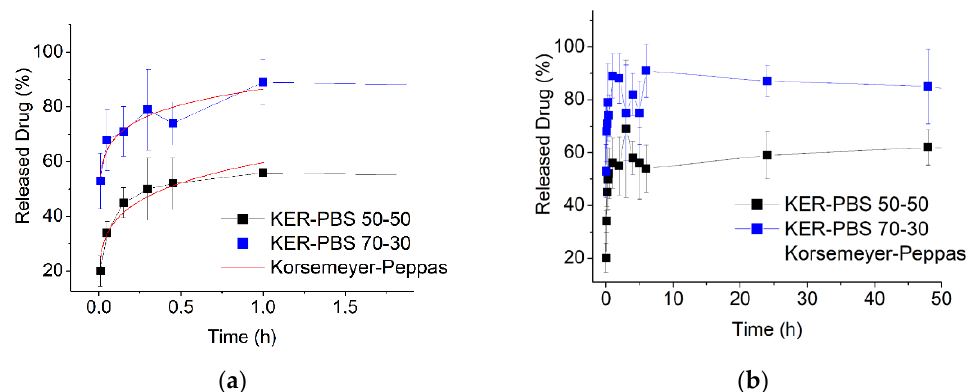
Figure 6. RhB release profiles of Keratin/PBS 50/50 and 70/30 electrospun mats: ( a ) initial RhB release profiles fitted by Korsemeyer-Peppas model, ( b ) complete RhB release profiles.